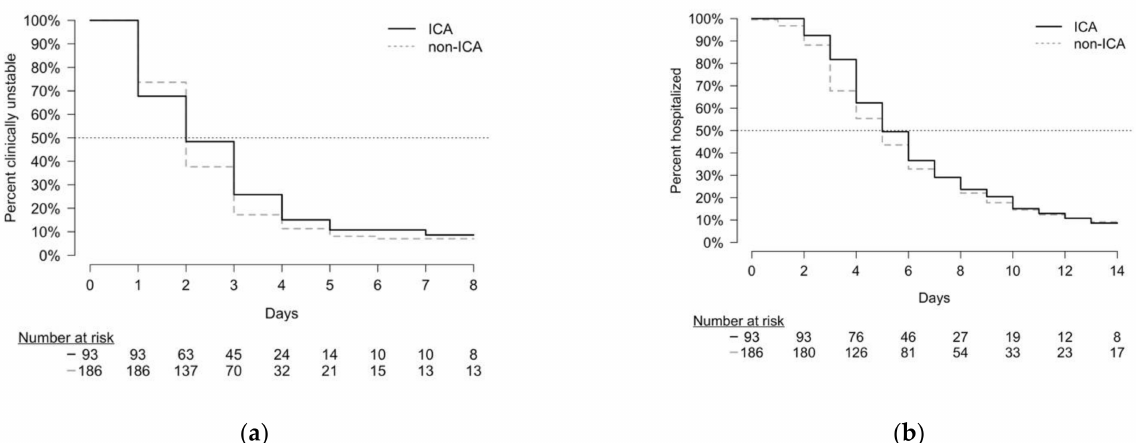
Figure 3. Kaplan–Meier curves for immunocompromised adults (ICA) and non-immunocompromised adults (non-ICA). The black lines represent ICA, and grey dashed lines represent non-ICA. ( a ) Kaplan–Meier curve for time to clinical stability (TCS); ( b ) Kaplan–Meier curve for length of hospitalization